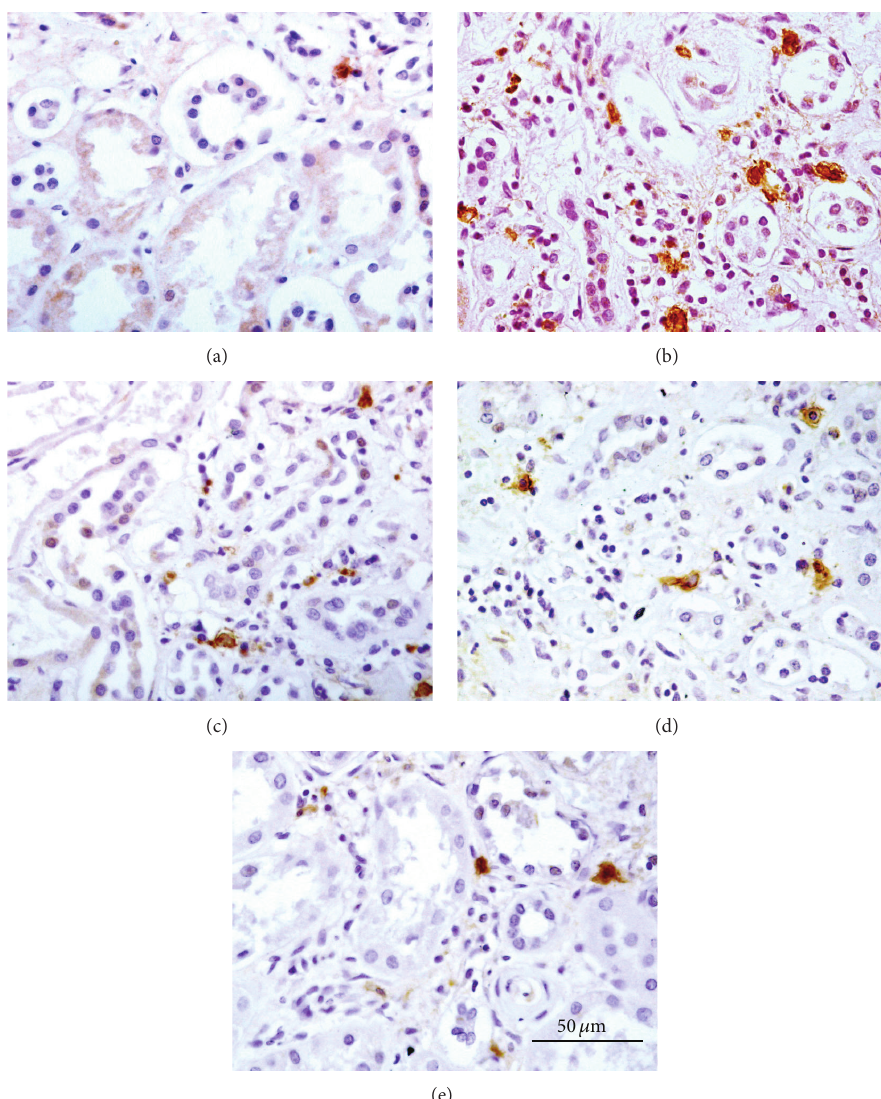
Figure4:LightmicroscopyofimmunohistochemicalstainwithCD68.Kidneytissuesections(4 𝜇 m)werestainedwiththephagocyticmarker CD68 (brown) and examined under a Zeiss A2 imaging microscope (Carl Zeiss, Hamburg, Germany). Immunoreactive cells are